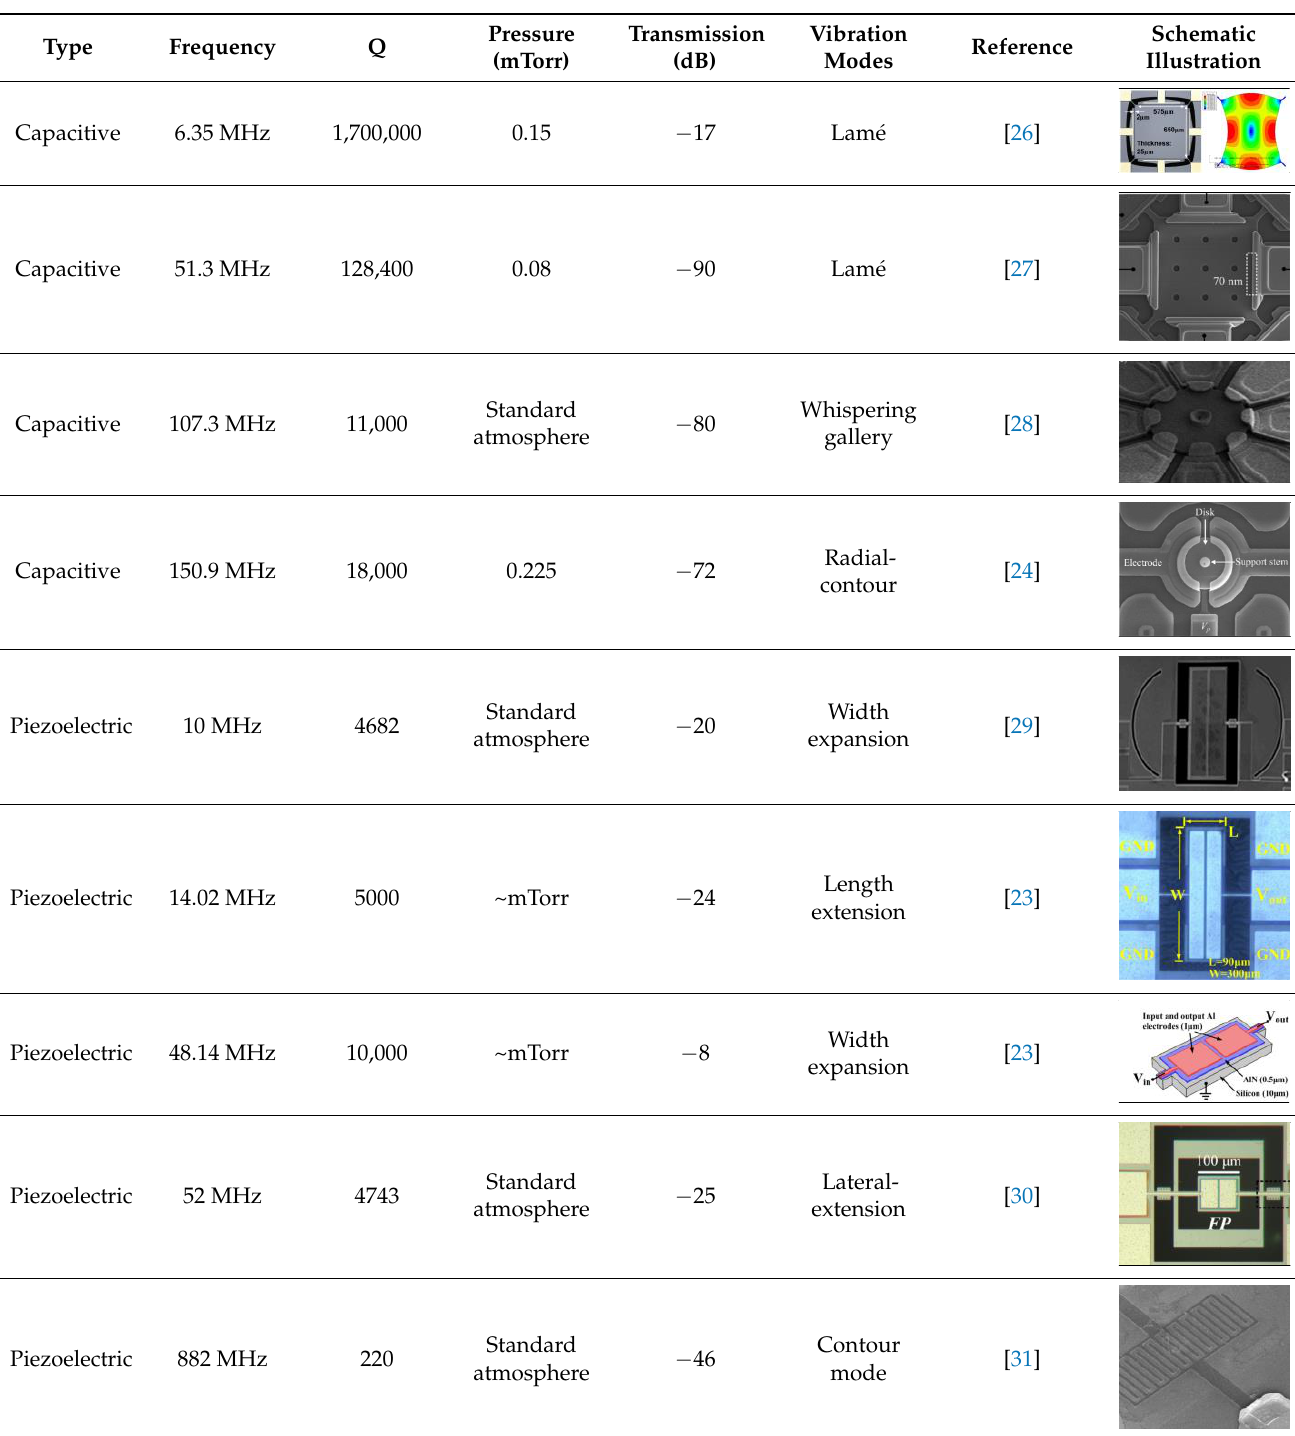
Table 2. Summary of representative different modes resonators in specific applications.